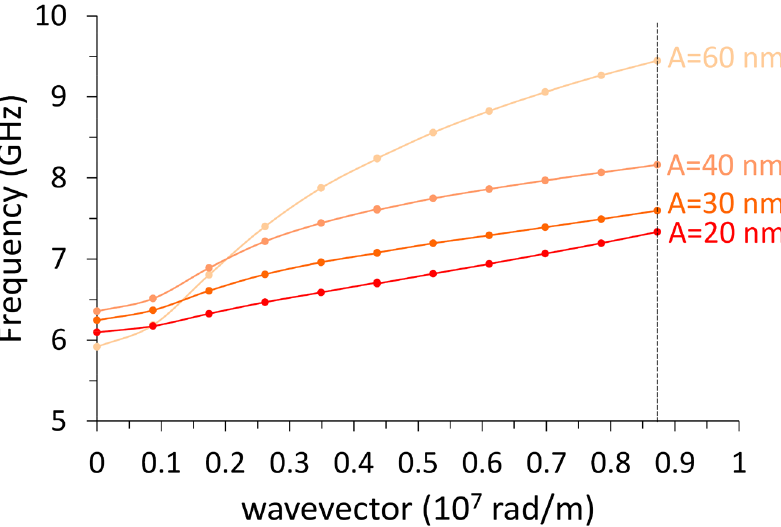
Figure 11. Dispersion relations of the edge mode with k ⊥ M , in a film with progressive undulation amplitude A, from A = 20 nm (4-stripe system) to A = 60 nm (12-stripe system), indicated by the same red shades, from the darker to lighter, of Fig. 5. No periodicity is expected along the propagation direction ( y -axis): the vertical dashed line marks the limit wavevector in the calculations. The first three systems show a progressive frequency increase, but note how the 12-stripe edge dispersion (in black) qualitatively differs from the others, due to the strongest demagnetizing fields.